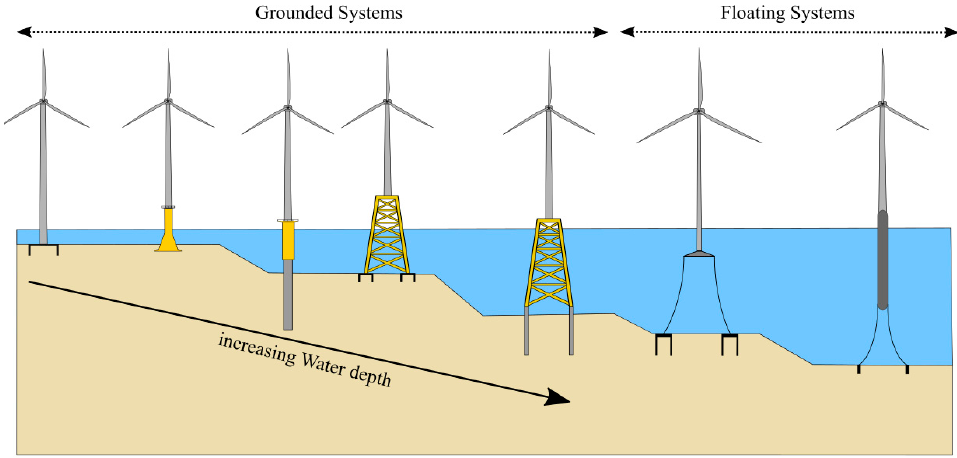
Figure 3. Commonly used foundations.